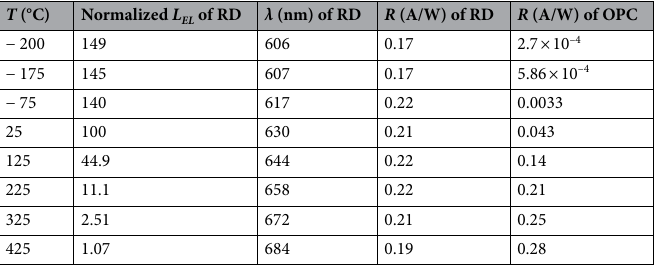
Table 6. Normalized integrated EL signal, light wavelength and responsivity of RD-RD and RD-OPC 33,34 .